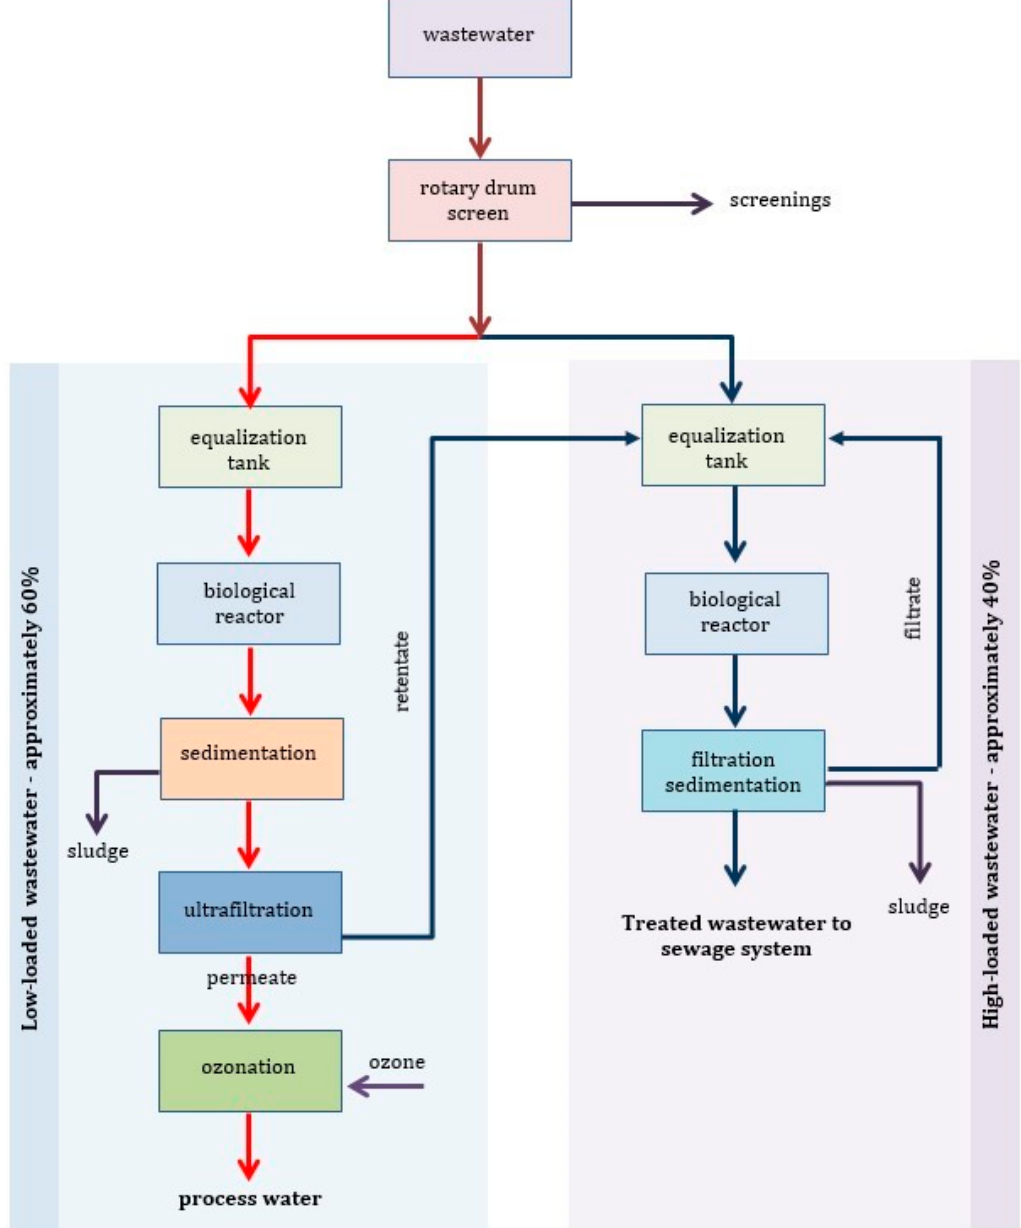
Figure 3. The block diagram of the technology proposed within the ICBTOS project.